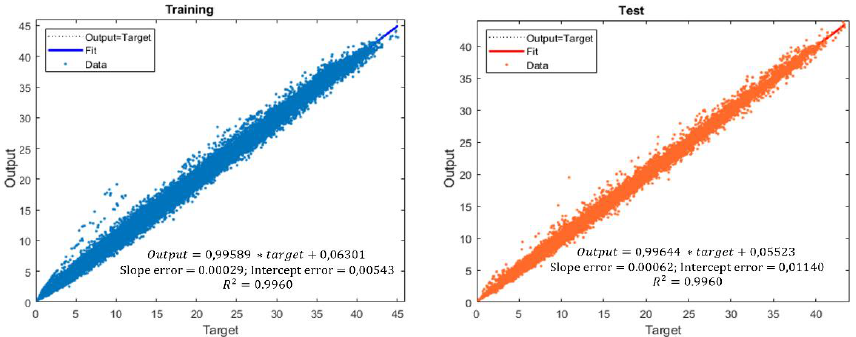
Figure 7. Results of I UV = f(I GH ,  ,Cc) , using ANN model 9.